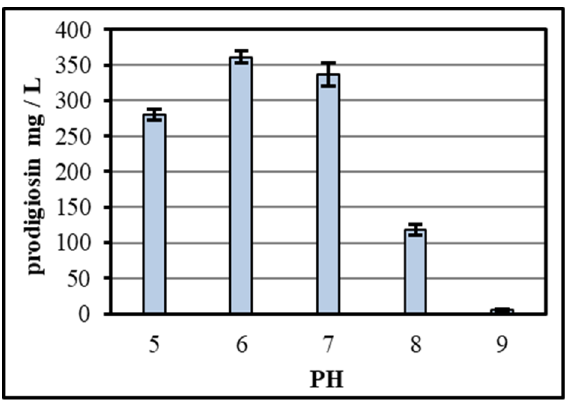
Fig 4. The effect of pH on prodigiosin production by S. marcescens in chemically defined liquid